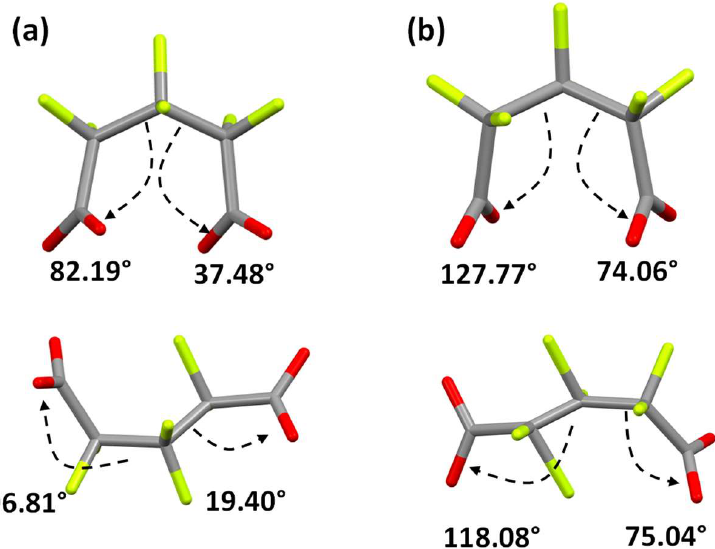
Figure 9. Torsion angles in the HFG ligands observed in the asymmetric unit for the compounds ( a ) α-Sm and ( b ) β-Sm.